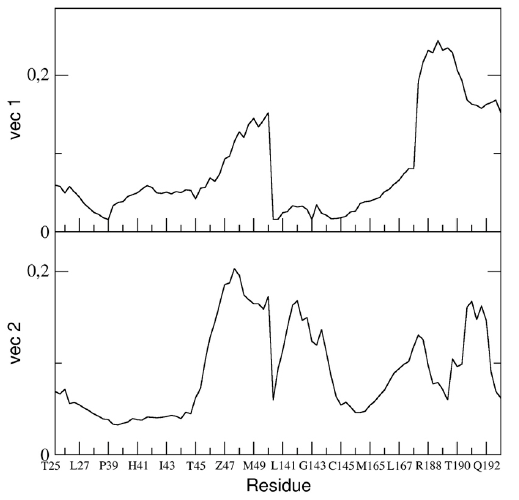
Figure 10. Absolute components of the first two backbone eigenvectors for the residues describing the binding pocket in the dimeric form of the 3CLpro.